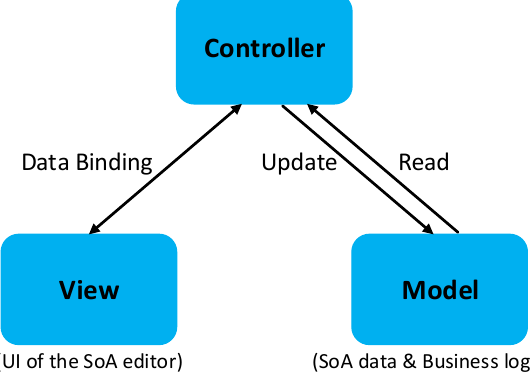
Figure 10. The SoA editor design in